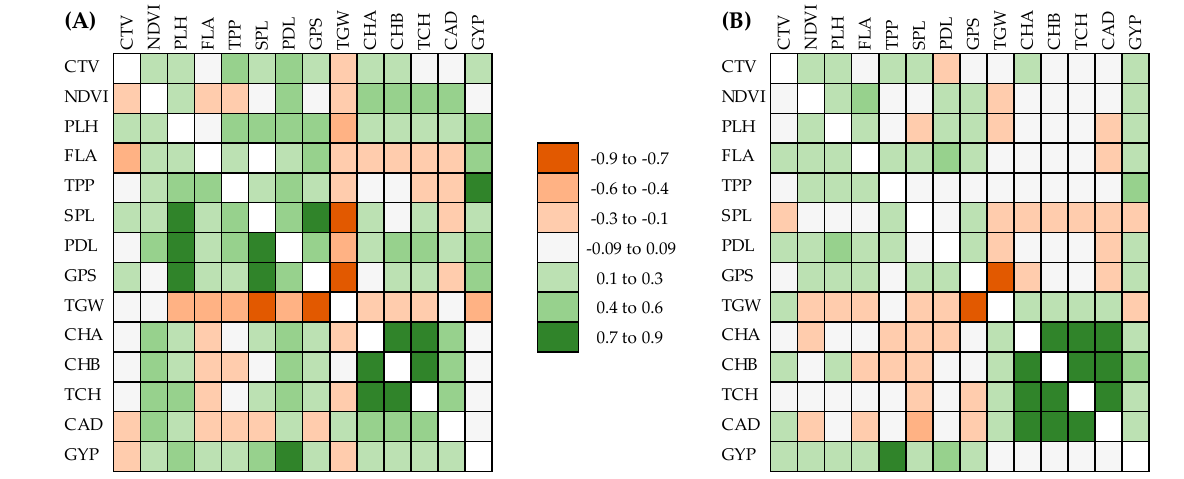
Figure 4. Correlation matrix of traits based on principal component analysis in ( A ) Parents and ( B ) Crosses under optimal (below diagonal) and YR-stress conditions (above diagonal). The colors brown and green represent positively and negatively correlated parameters, respectively, with increasing color intensity reflecting a higher coefficient. Key: CTV = Canopy temperature at veg- etative stage, NDVI = Normalized Differential Vegetative Index, PHT = Plant height, FLA = Flag leaf area, TPP = Tiller Plant-1 PDL = Peduncle Length, SPL = Spike Length, GPS = Grains Spike-1, TGW = Thousand Grain Weight, GYD = Grain Yield Plant-1), CHA = Chlorophyll A, CHB = Chloro- phyll B, TCH = Total Chlorophyll, CAD =